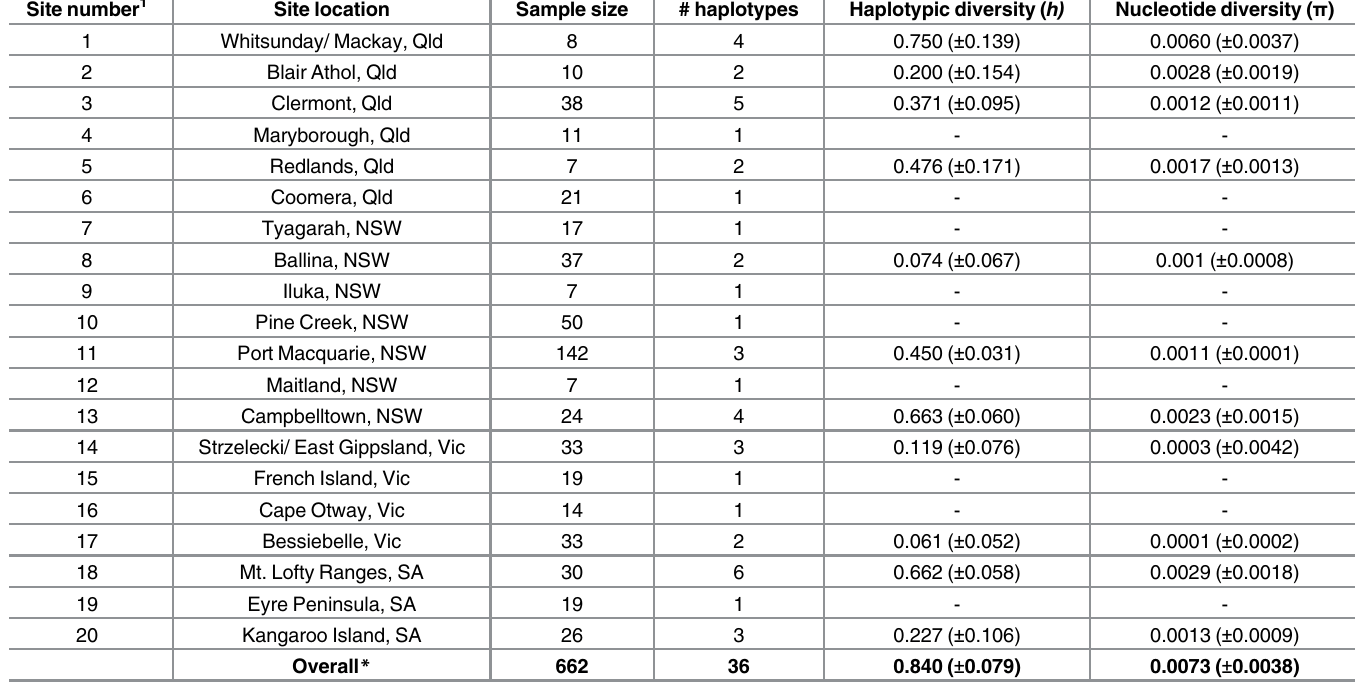
Table 1. Mitochondrial diversity in the 20 sampled sites (n > 7) across the range of koala, showing the number of haplotypes identified, haplotypic ( h ) and nucleotide ( π ) diversity and